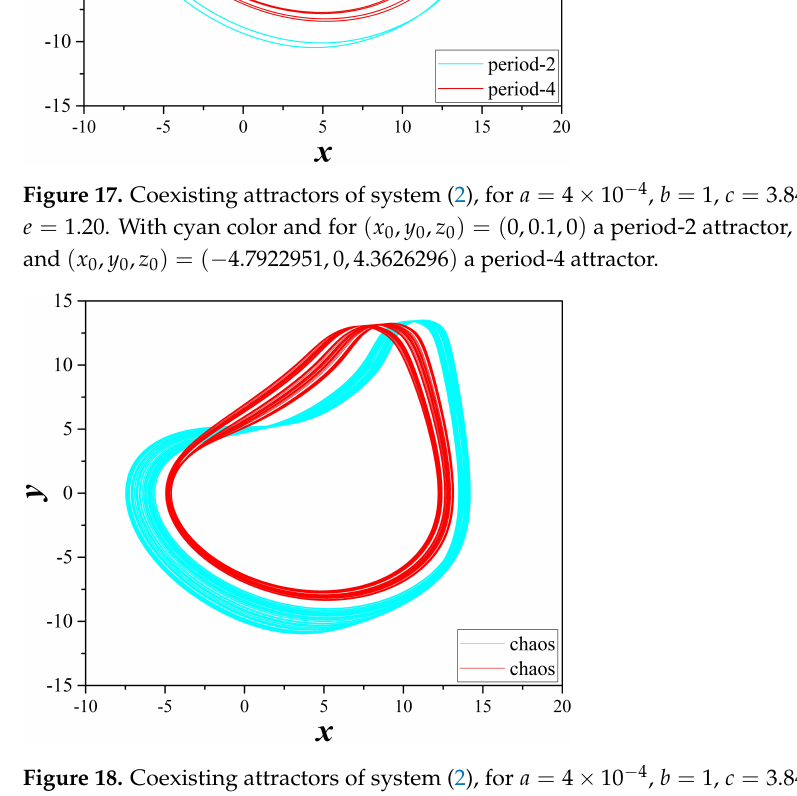
Figure 18. Coexisting attractors of system (2), for a = 4 × 10 − 4 , b = 1, c = 3.846 × 10 − 4 , d = 1 and e = 1.26. With cyan color and for ( x 0 , y 0 , z 0 ) = ( 0,0.1,0 ) a chaotic attractor, while with red color and ( x ) = ( − 4.6300732,0,4.5716944 ) a different chaotic 0 , y 0 , z 0